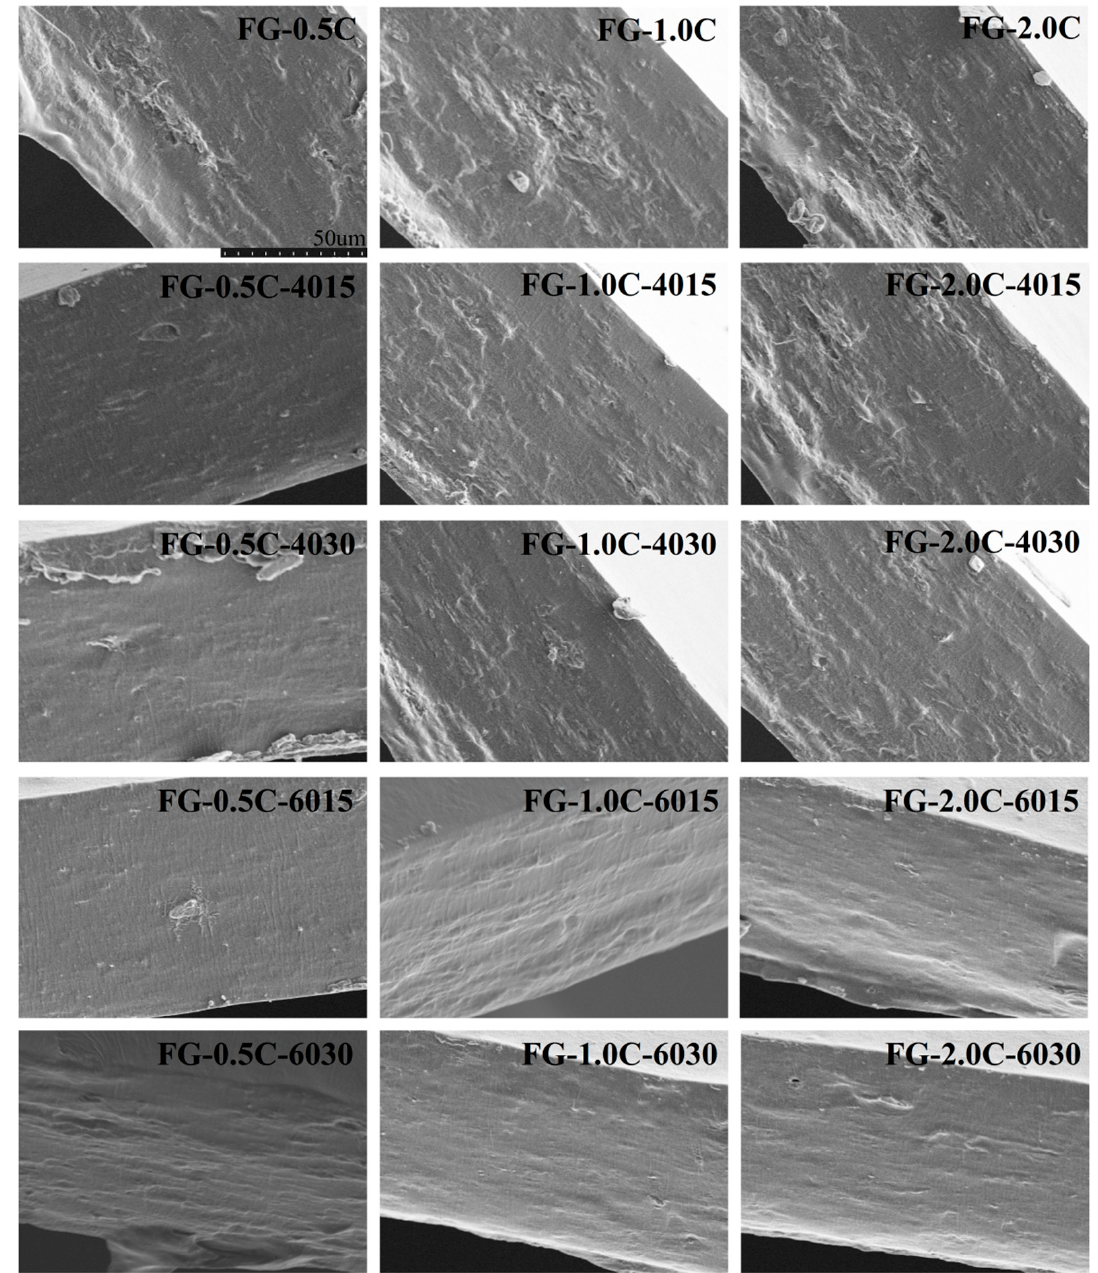
Figure 5. E ff ect of sonication on SEM micrographs (magnification: 2000 × ) of crosssections of flaxseed Figure 5. Effect of sonication on SEM micrographs (magni fi cation: 2000×) of crosssections of flaxseed gum films incorporated with gum films incorporated with carvacrol.